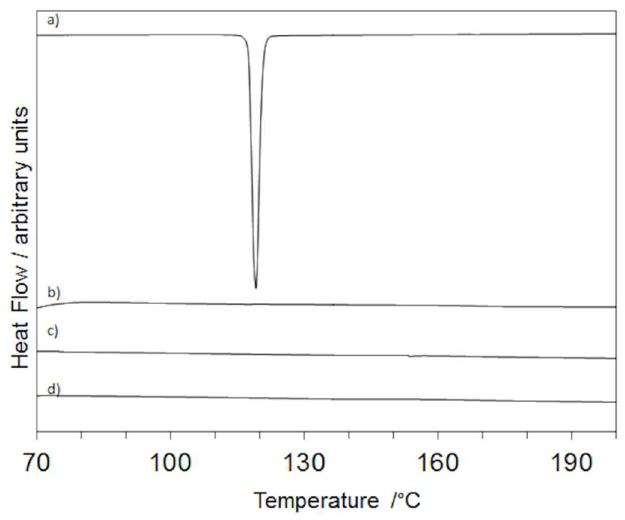
Figure 4. DSC curves of firocoxib ( a ), PVP:SOL (1:1) ( b ), F:PVP:SOL (1:2:2) ( c ), and F:PVP:SOL (1:4:4) ( d ).